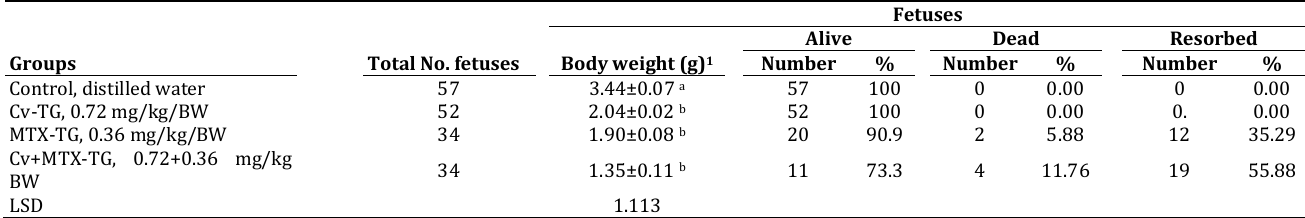
Table 1. Effect of P. glycoprotein inhibitor carvedilol on body weigh, total number of alive, dead , and resorbed fetuses at one day before parturition